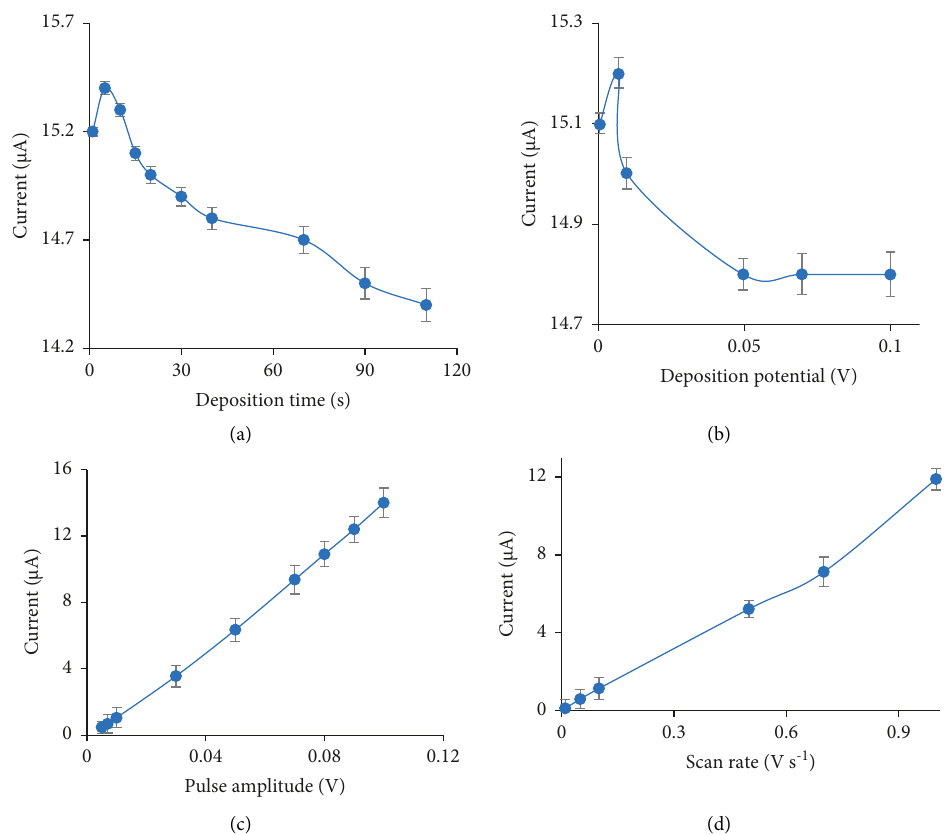
Figure 5: Influence of the accumulation time (a), deposition potential (b), pulse amplitude (c), and scan rate (d) on the Ads-DP-ASVs anodic peak current of DCS (10nM) steroid at GCE vs. Ag/AgCl electrode at 100mVs − 1 scan rate; 7mV deposition potential of 0.007V; pulse amplitude of 70mV and BR solution of pH 2. ≈ y = 0.6634x + 3.3922 R 2 = 0.9864